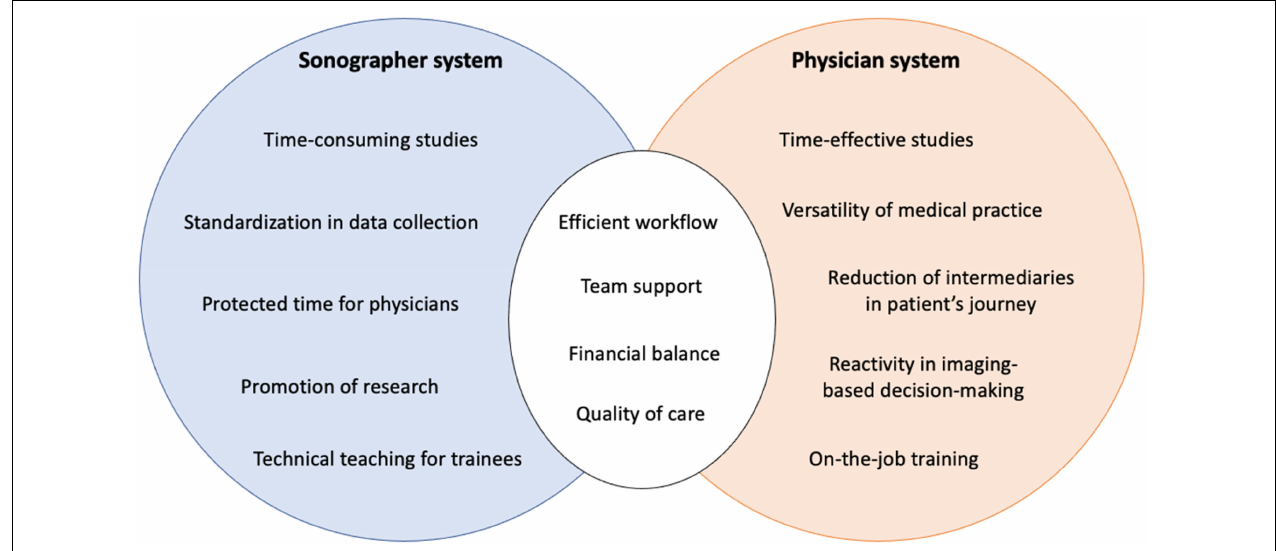
FIGURE 5 | Strengths, weaknesses and common objectives for the sonographer and the physician systems.